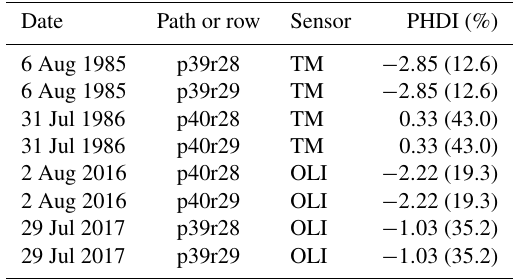
Table 1. Landsat images used to map agricultural extent. The Palmer hydrological drought index (PHDI) values were provided for the month of July. The percentage was calculated based on the values that occurred between 1984 and 2017. TM: thematic mapper. OLI: operational land